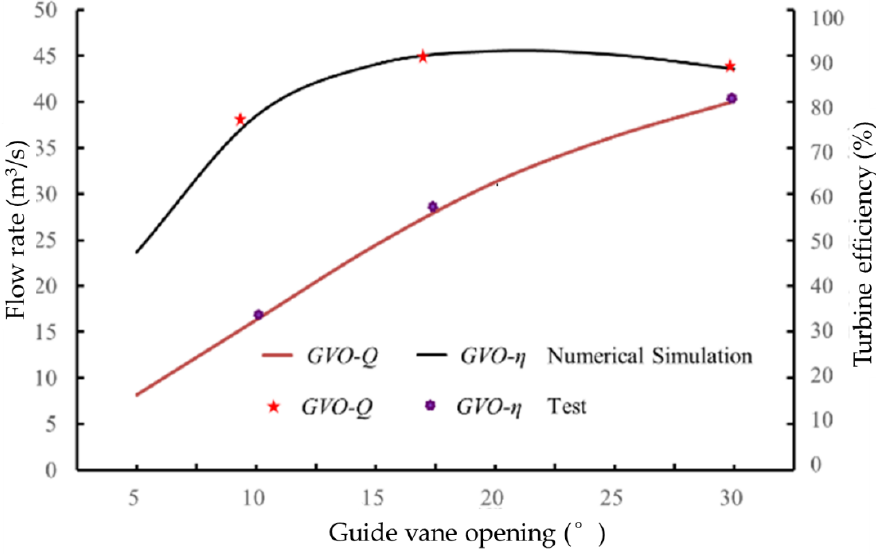
Figure 5. Reliability verification of external characteristics of hydraulic turbine .